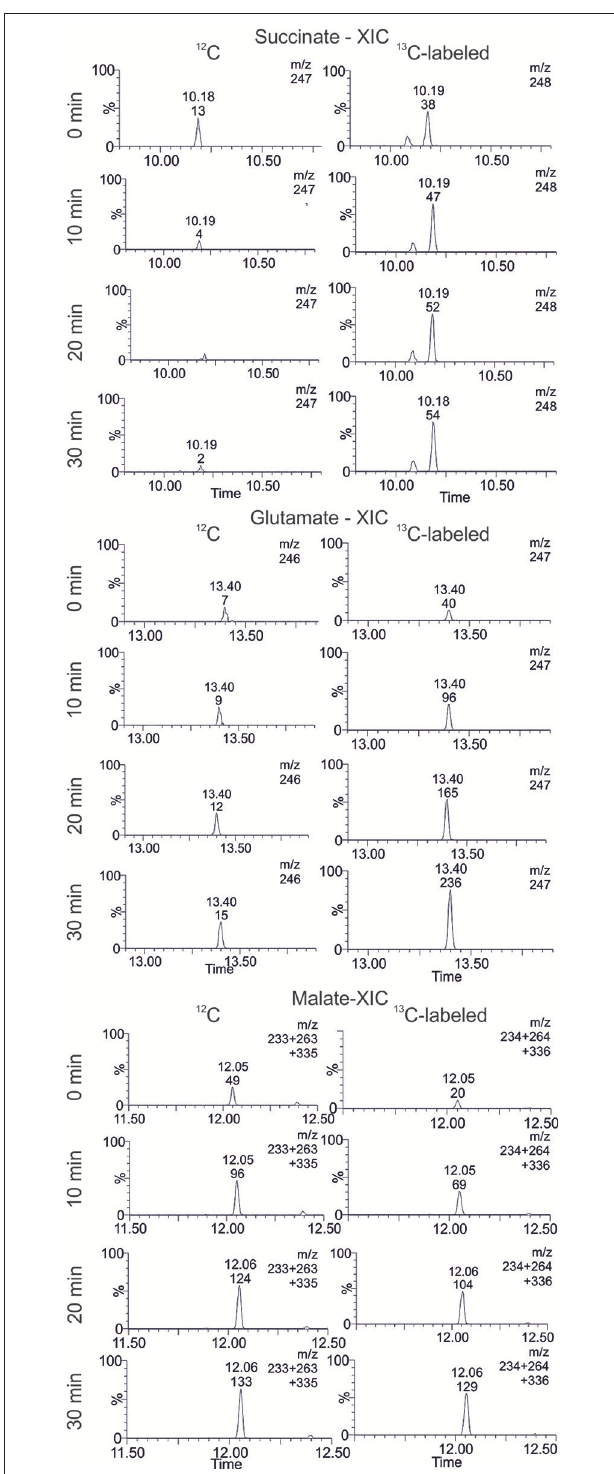
FIGURE 7 | Extracted ion chromatogram (XIC) of selected TCA cycle intermediates. The accumulation and dissipation of 12 C and 13 C labeled species during the isotopic labeling experiment with [1,5- 13 C]citrate in Lactobacillus brevis alcohol dehydrogenase ( Lb ADH) crude cell extract are displayed (corresponding results of KRED1- Pglu see Supplementary S2.4